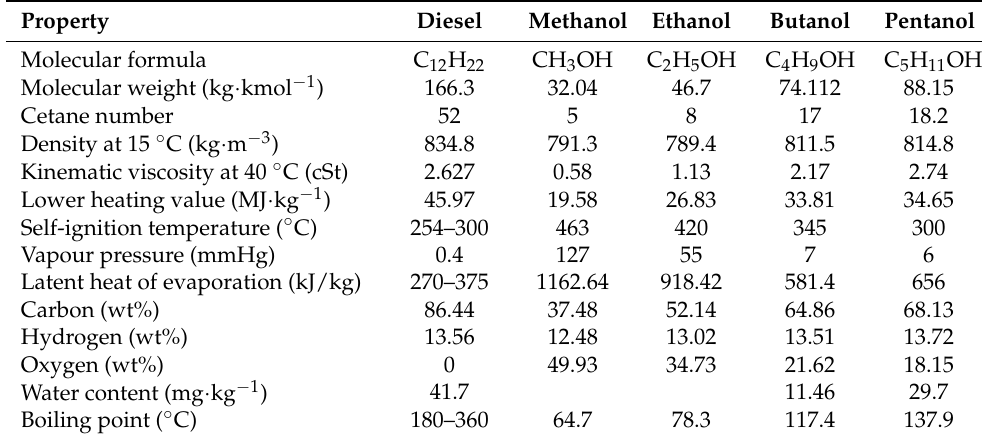
Table 1. Physical and chemical properties of neat tested fuels [90].